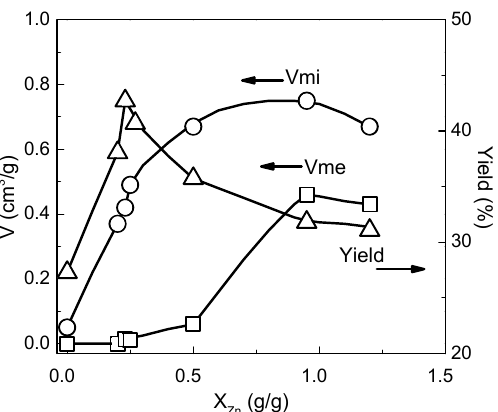
Figure 17. Molecules 2020 , 25 , x FOR PEER REVIEW